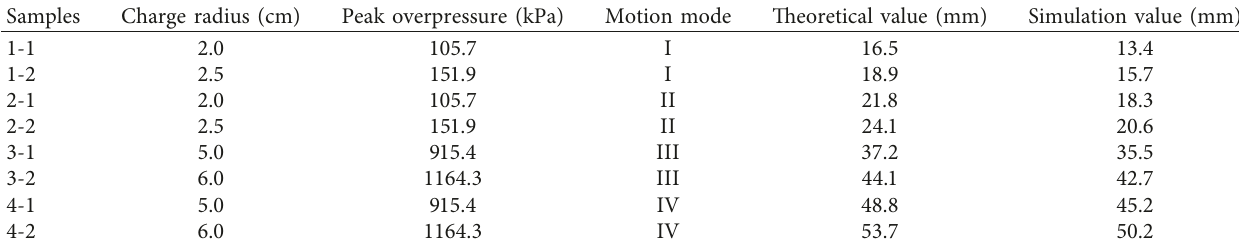
Table 3: Comparisons of theoretical and numerical simulation results.